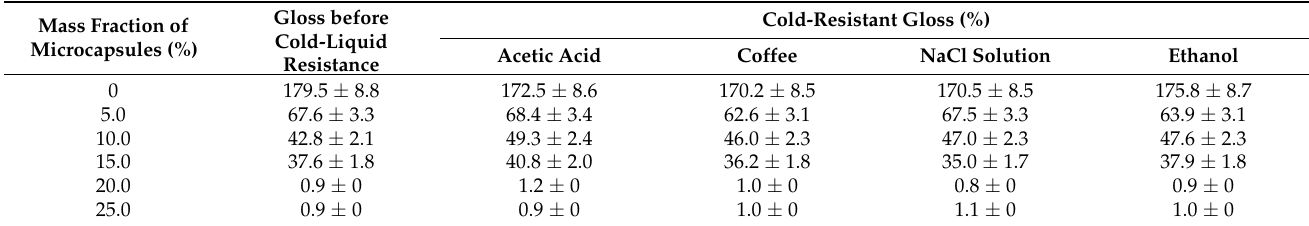
Table 12. Liquid gloss resistance of coating with different microcapsule